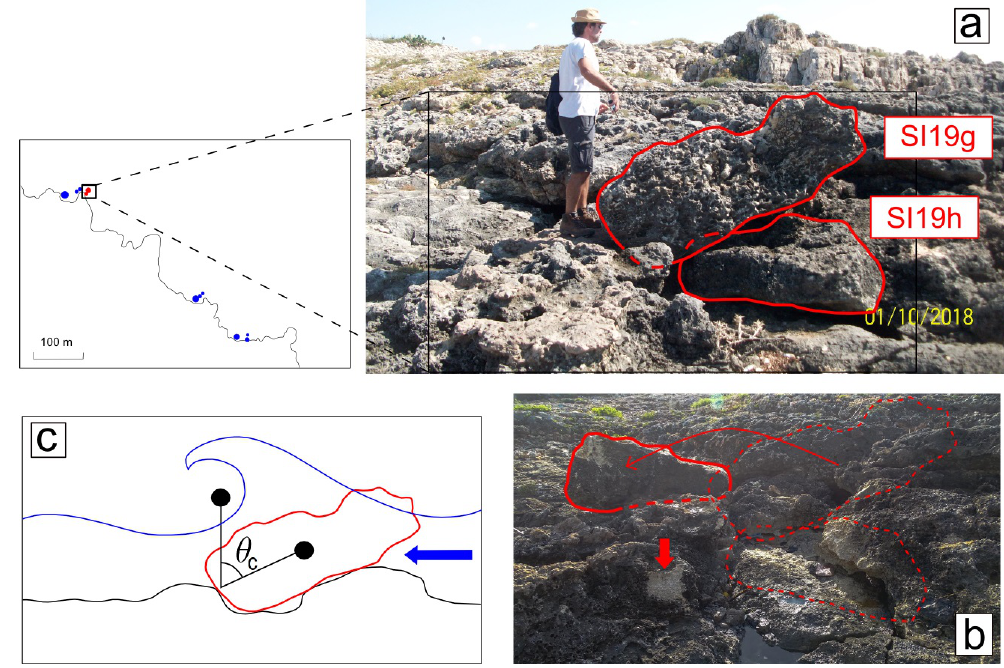
Figure A8. Comparison between pre- and post-storm event states: ( a ) pre-storm locations of Boulders g and h; ( b ) post-storm overturned positions of Boulder g (note the marks indicated by the arrow, probably the sign of the impact of a boulder on the bedrock); ( c ) angular threshold θ c